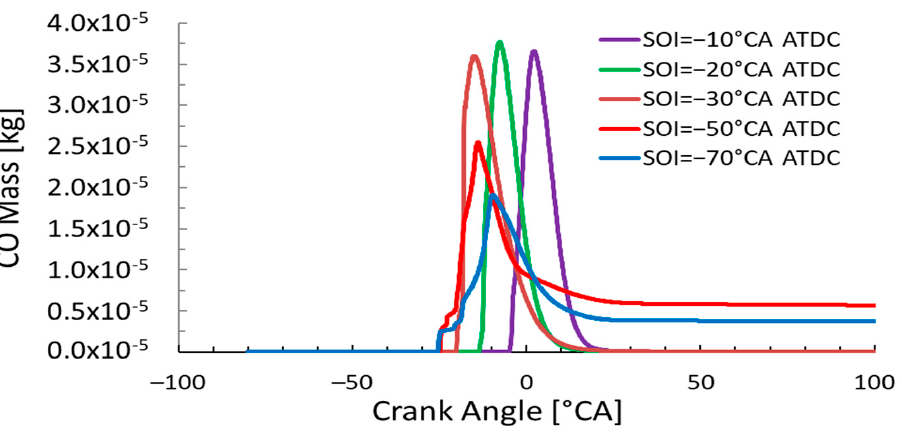
Figure 13. Effect of SOI timing on in-cylinder soot formation and oxidation history. The effect of injection timing on the evolution of CO in the combustion chamber according to ◦ CA during the compression and expansion strokes is presented in Figure 14.